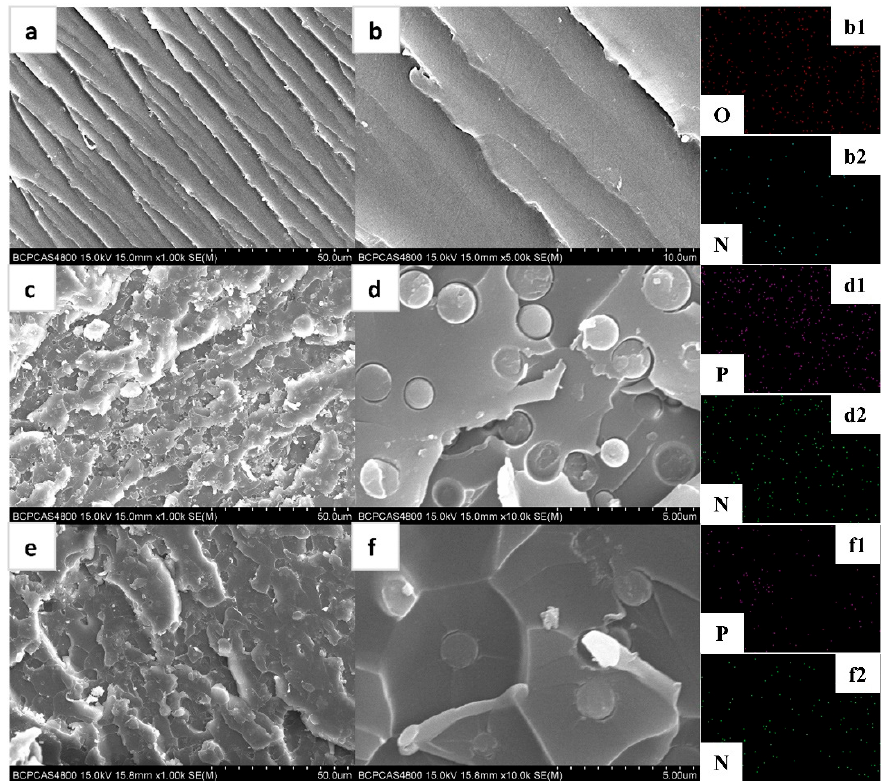
Figure 5. SEM and magnified SEM images of ( a , b ) EP, ( c , d ) EP/5% PZS, and ( e , f ) EP/5% PZS@ZIF- 67; ( b1 , b2 ) element mapping of EP; ( d1 , d2) element mapping of EP/5% PZS; ( f1 , f2 ) element mapping of EP/5%